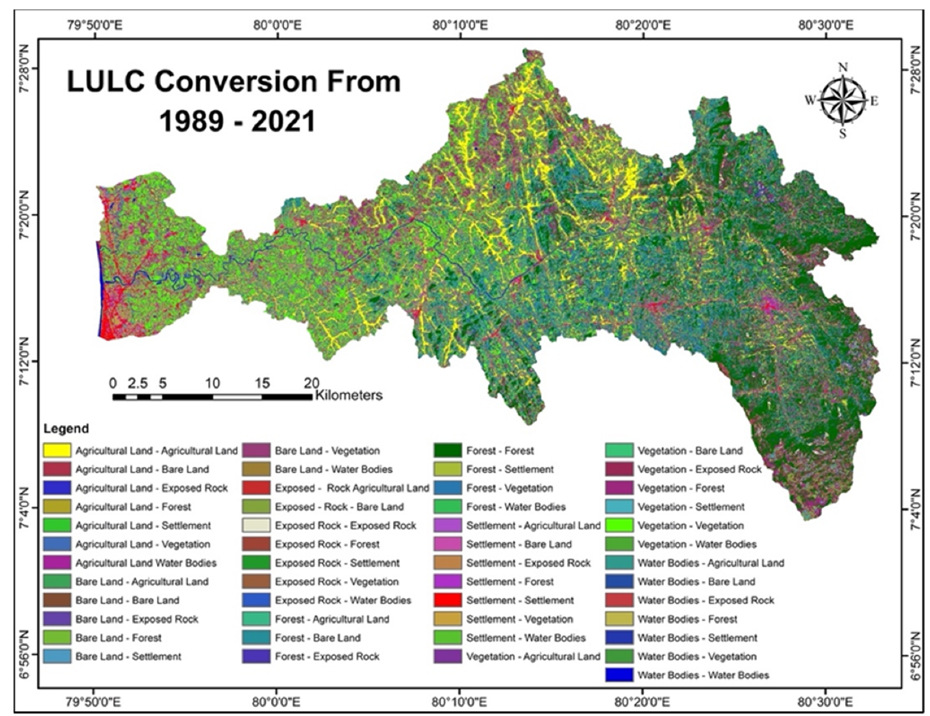
Figure 13. LU/LC conversion from 1989 to 2021 in Maha Oya River Basin. Table 15. Primary Conversions of LU/LC types in MORB from 1989 to 2021.